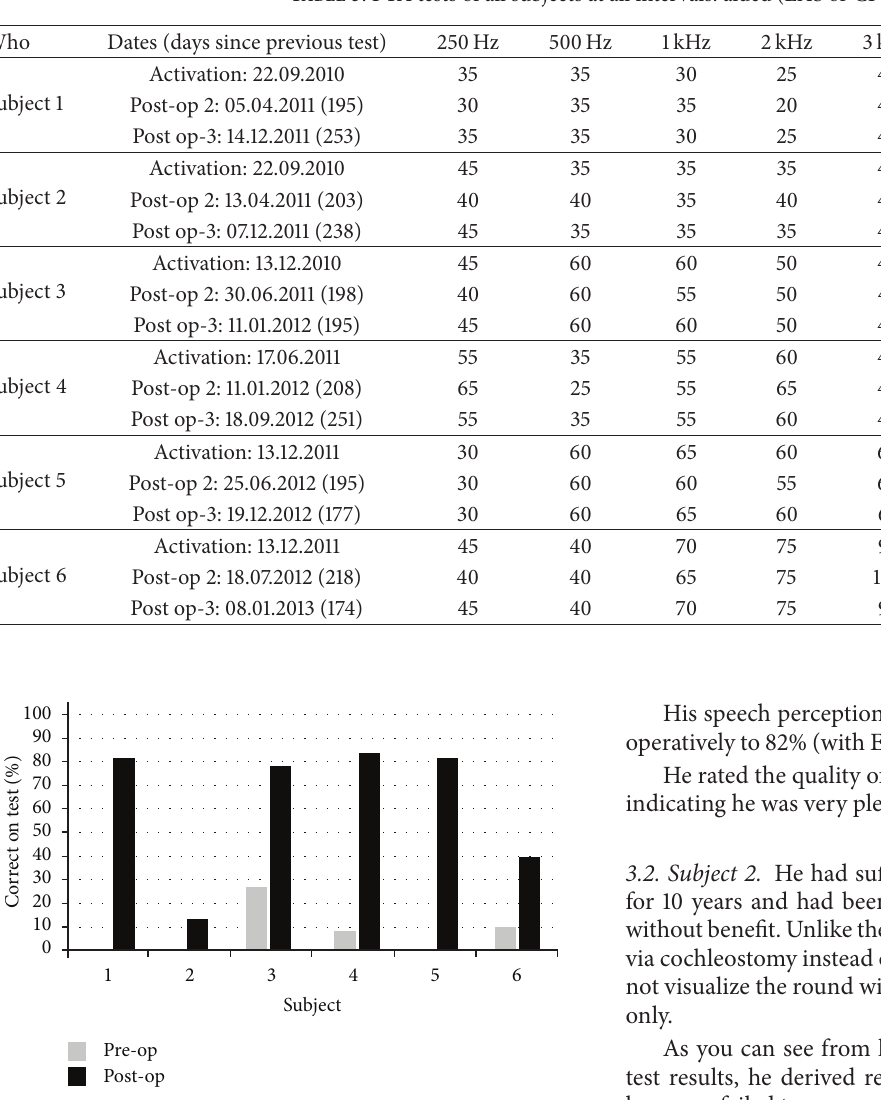
Figure 7: Pre- and Postoperative Speech Perception Scores.